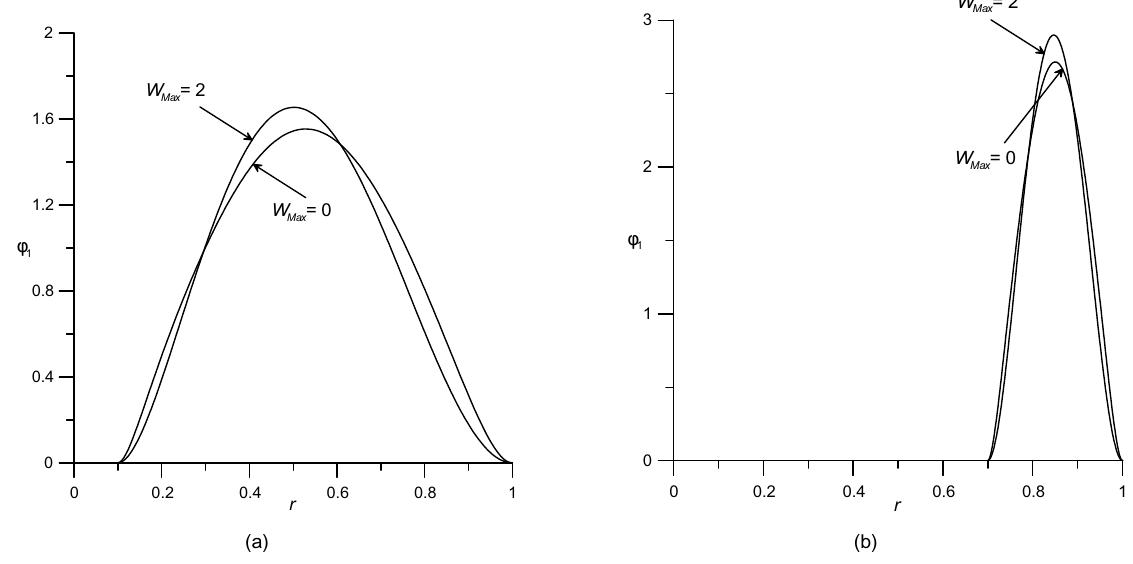
Fig. 14. The first mode shape for flat and deflected ( W Max = 2 ) clamped-clamped plate of inner radius (a) b = 0 . 1 and (b) b = 0 . 7 .